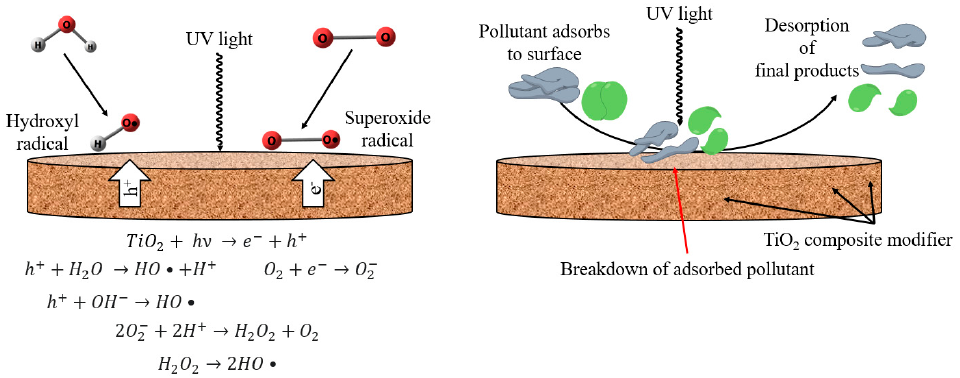
Figure 1. Mechanism of membrane cleaning ability after UV irradiation.